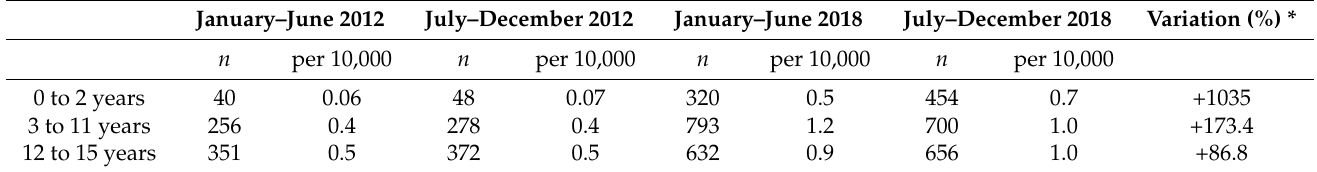
Table 1. Characteristics of children who received at least one opioid: comparison between 2012 and 2018. Table 2. Morphine dispensations by age group, comparison of year 2012 and year